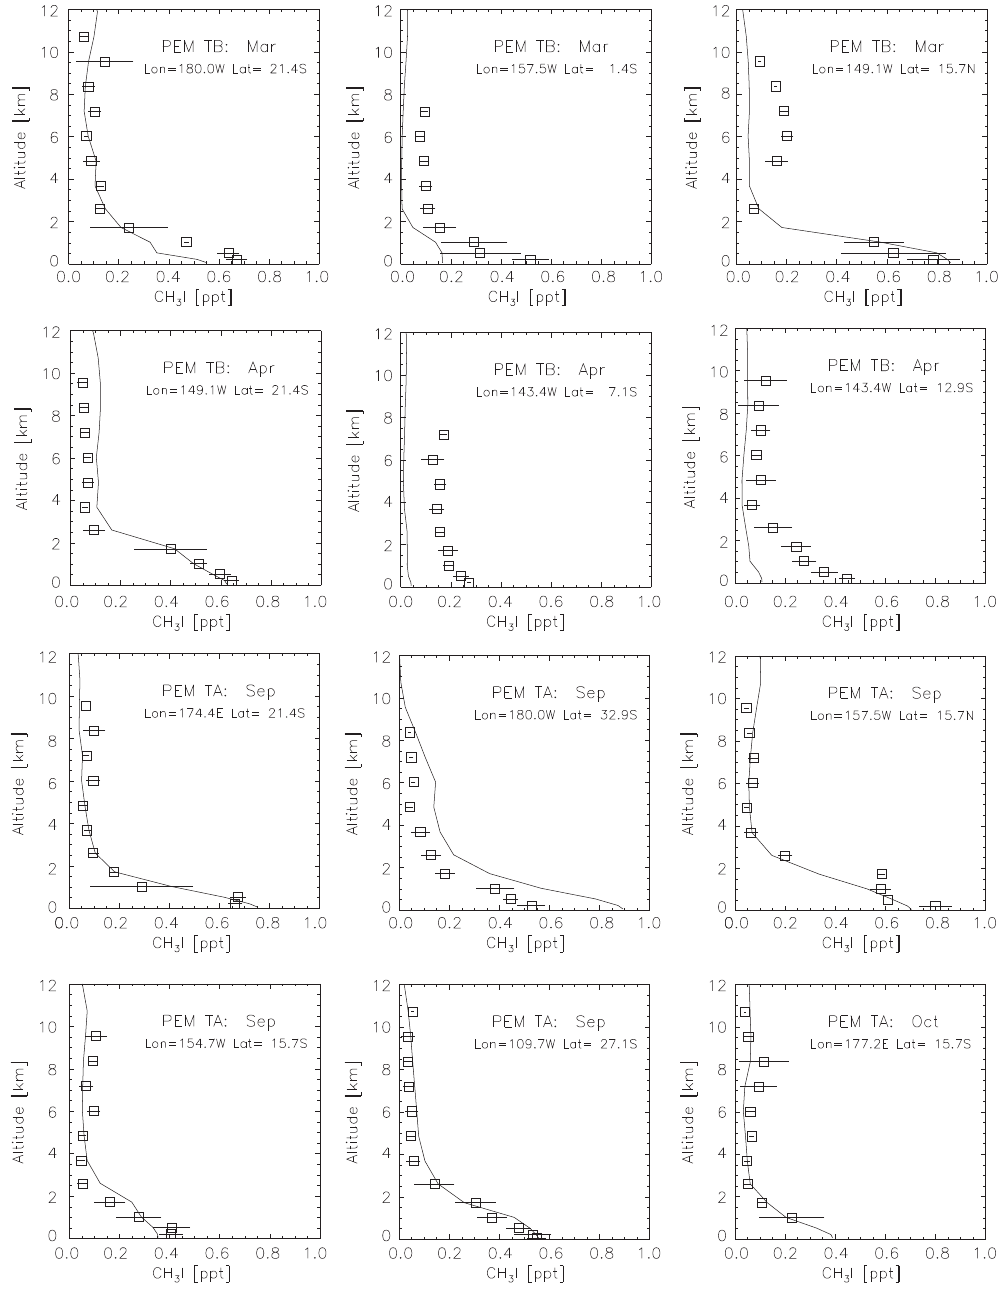
Fig. 4. Vertical profiles of CH 3 I concentrations measured from aircraft and simulated by model. Horizontal bars are standard deviations computed from the individual measurements. Solid black lines denote the corresponding model